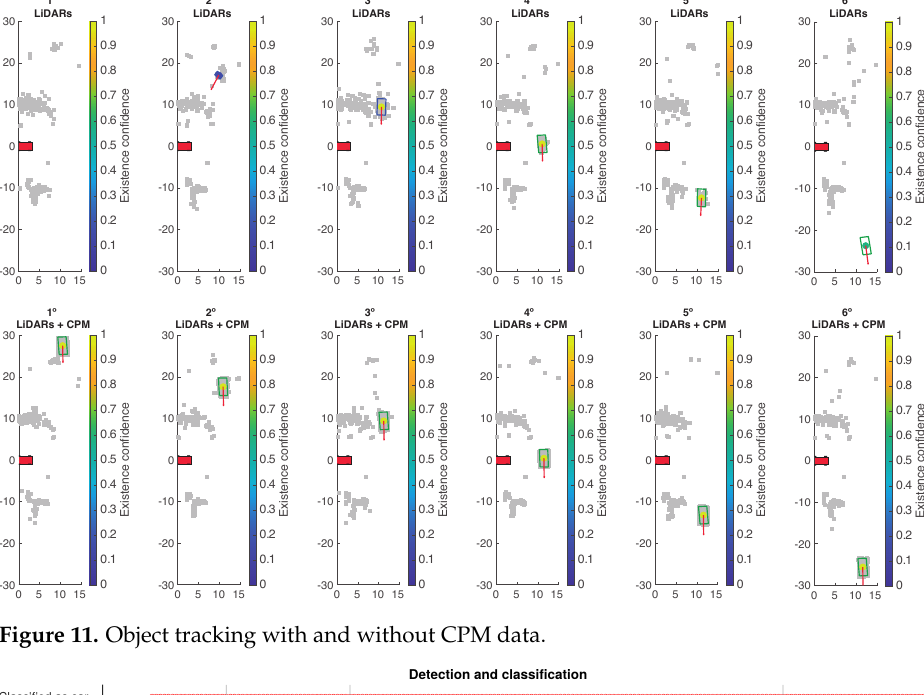
Figure 11. Object tracking with and without CPM data.